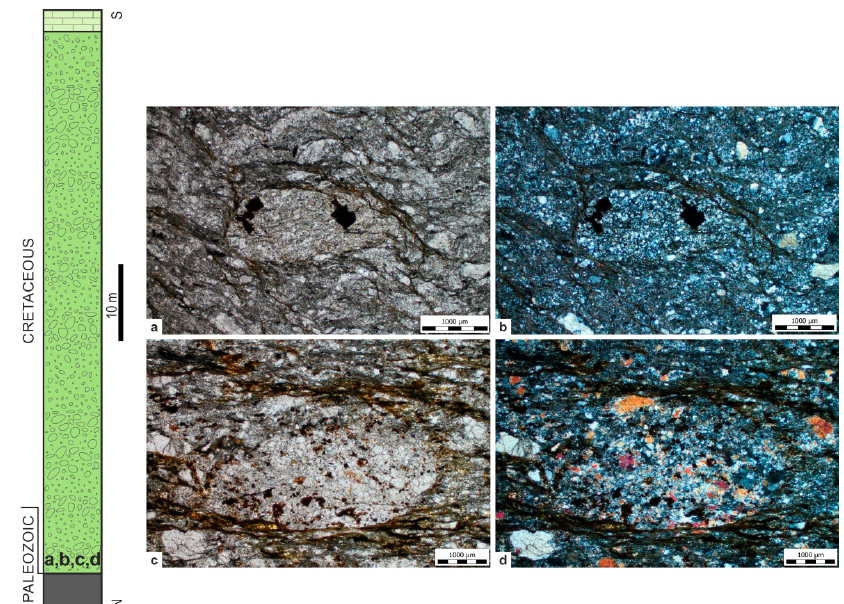
Figure 6. Pebble textures from Sampling Point 1 without ( left ) and with ( right ) polarizing analyzer filter: ( a , b ) crenulate cleavage and opaque grains in a mylonitized greywacke, thin section M–1.3.; ( c , d ) cleavage in a mylonitized greywacke, thin section M–1.8.